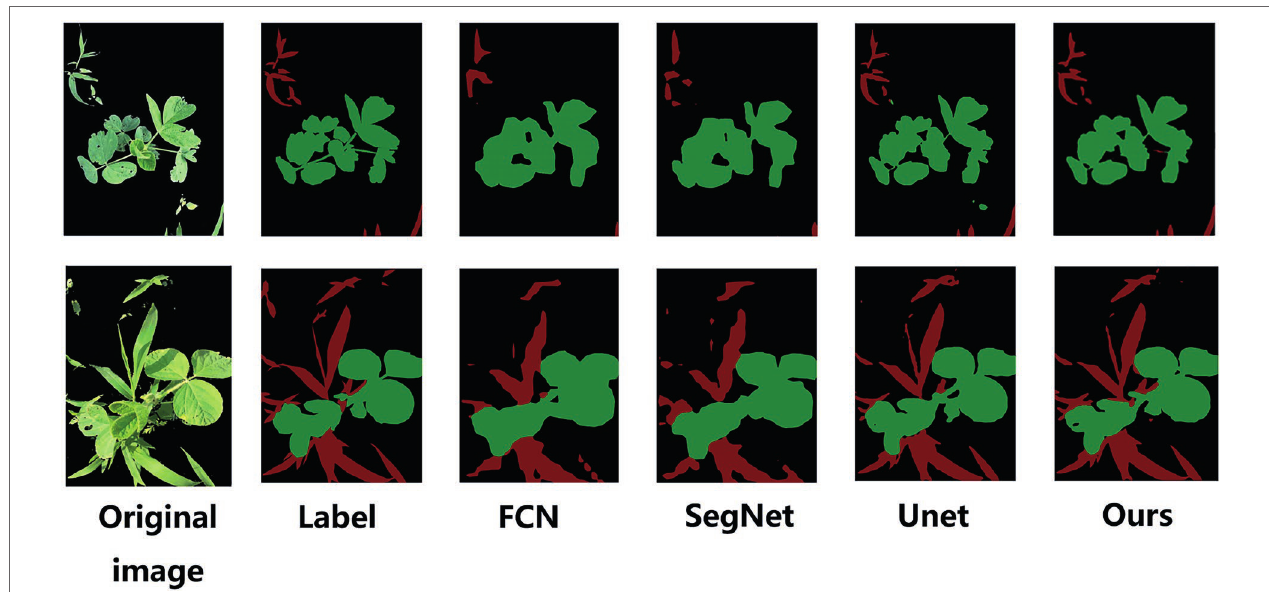
FIGURE 12 | Comparison of the segmentation effects of the different models.